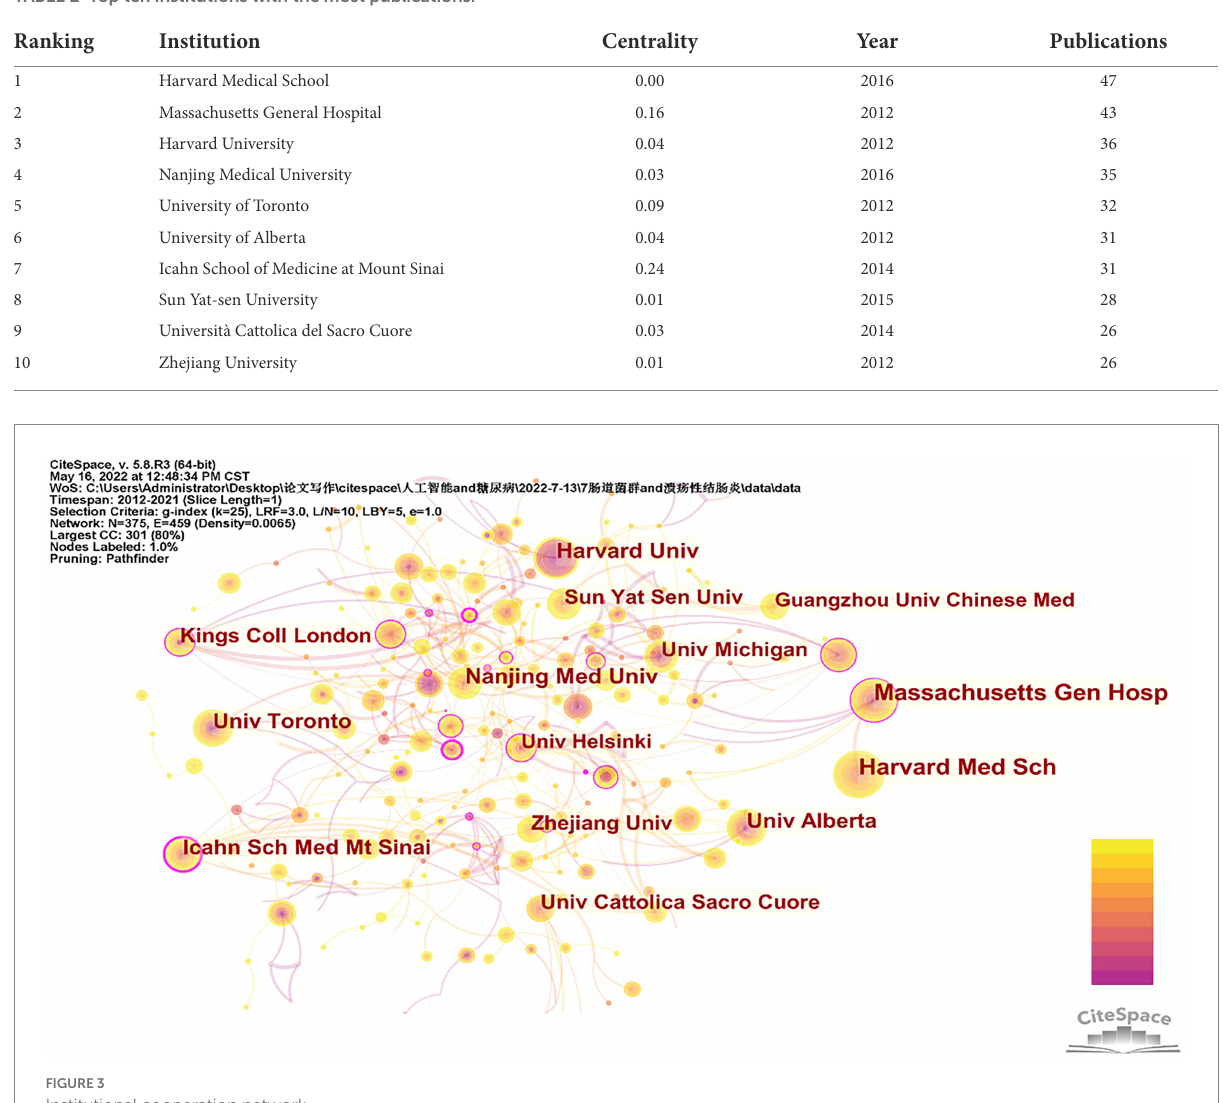
TABLE 2 Top ten institutions with the most